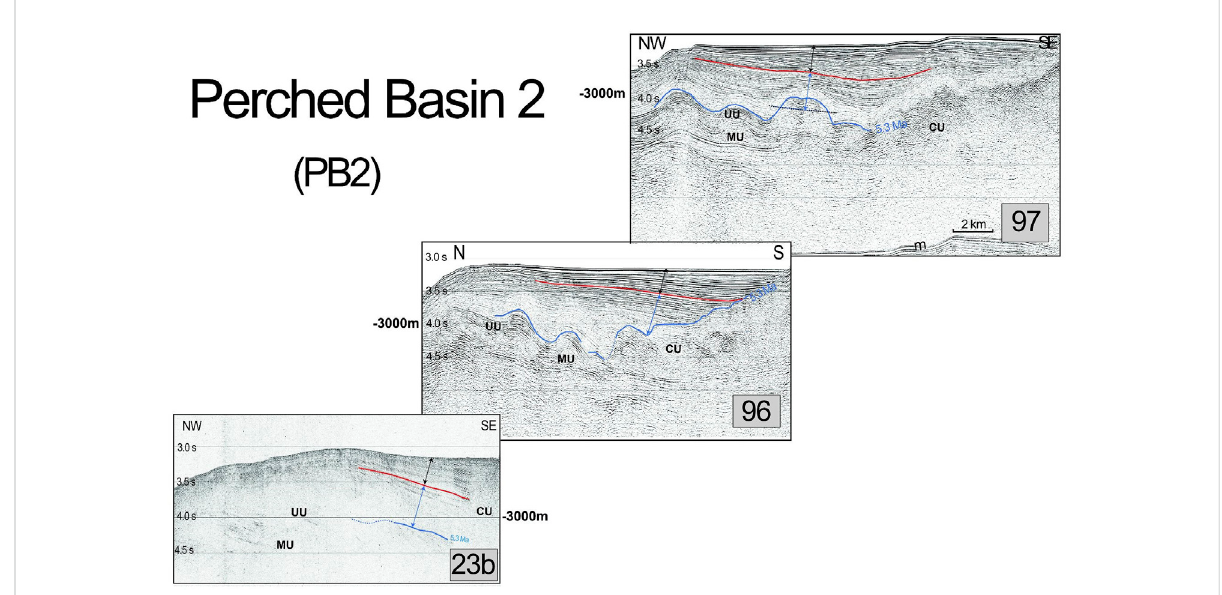
FIGURE 9 Two-way travel time seismic sections (zooms) 23b, 96, 97 from west to east off Boumerdès, displaying growth strata below the perched surfaces PS2. Zooms are located on Figure 2. Same caption as in Figure 8. Because of salt tectonics (MU = Mobile Unit), we choose to place the doublearrowsatlocationsaboveMessinianchaoticunits(CU)orwherethedomingisminimal.ForPro fi le97,weusethehalf-meanheightofthesalt dome as reference in order to estimate the PGS